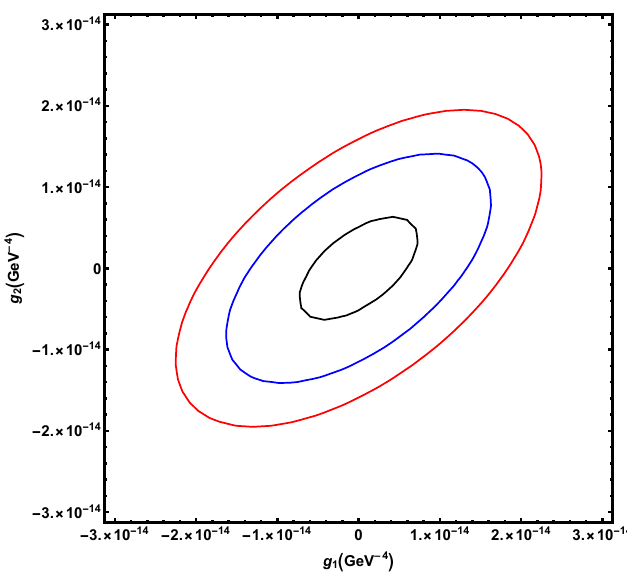
√ s = 3000 GeV and L = 5000 fb − 1